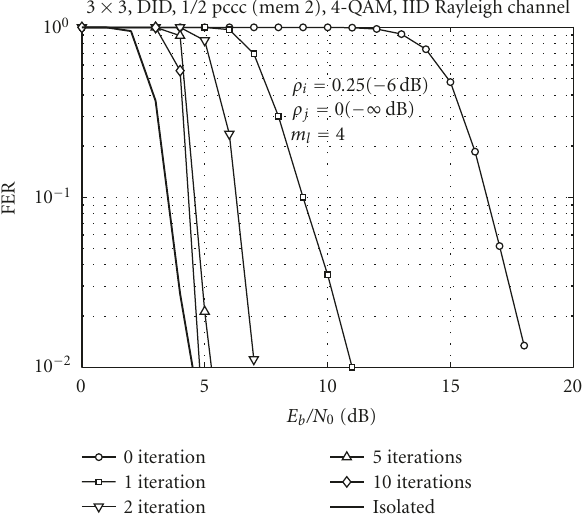
Figure 9: Iterative behavior of SAIC-DID exchanging soft APP